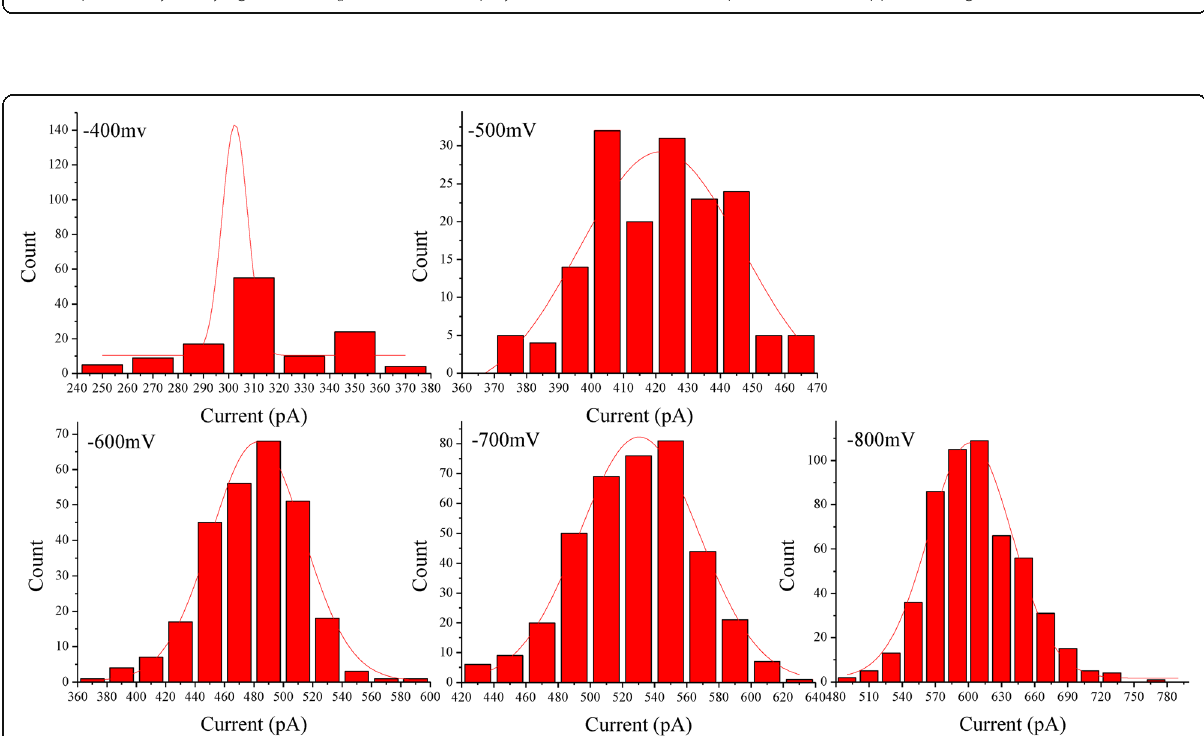
Fig. 4 The histograms of the mean current amplitude of translocation events measured for aggregated ABTS (cid:129) + at different voltages ( − 400, − 500, − 600, − 700, − 800 mV) in 0.1 M KCl, 0.1 M PBS, pH 7.0. All histograms were fitted with Gaussian